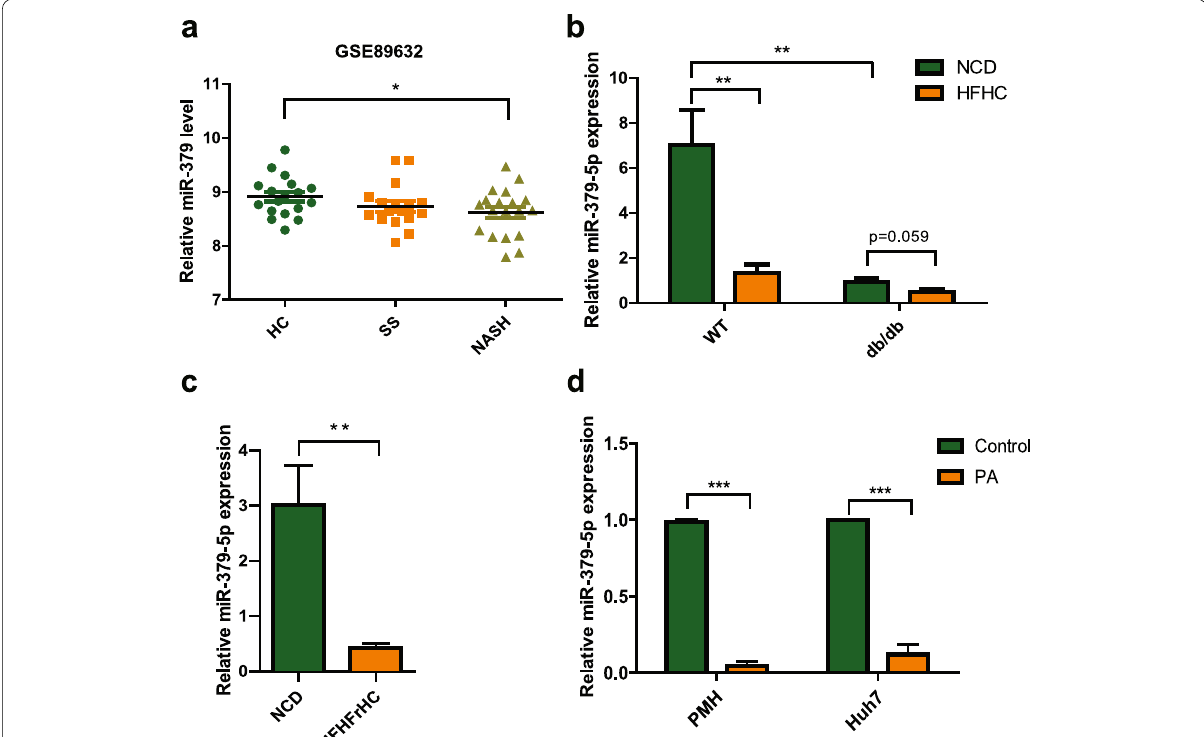
Fig. 1 Expression of miR-379-5p is decreased in vitro/in vivo/in clinic. a Hepatic miR-379 levels between healthy control (HC, n 18), simple = steatosis (SS, n 17) and NASH patients ( n 19). Data were derived from GEO database (GSE89632). In HC group, 6 healthy living liver donors = = with fibrosis symptoms were excluded. b db/db mice and their lean littermates (wild type (WT)) were fed with a NCD or HFHC diet for 20 weeks respectively, and miR-379-5p in the liver was examined by RT-PCR. n 5 in each group. c MiR-379-5p was detected by RT-PCR in the livers of = C57BL/6 J mice fed with a NCD or HFHFrHC diet for 20 weeks. n 9–10 in each group. d Primary mouse hepatocytes (PMH) and Huh7 cells were = stimulated with 0.5 mM PA for 24 h, and the expression of miR-379-5p in the cells was detected by RT-PCR. For a, c and d, two-tailed student’s t-test was used to calculate statistical significance, while for b, One-Way ANOVA test was used (* P < 0.05, ** P < 0.01, *** P < 0.001)